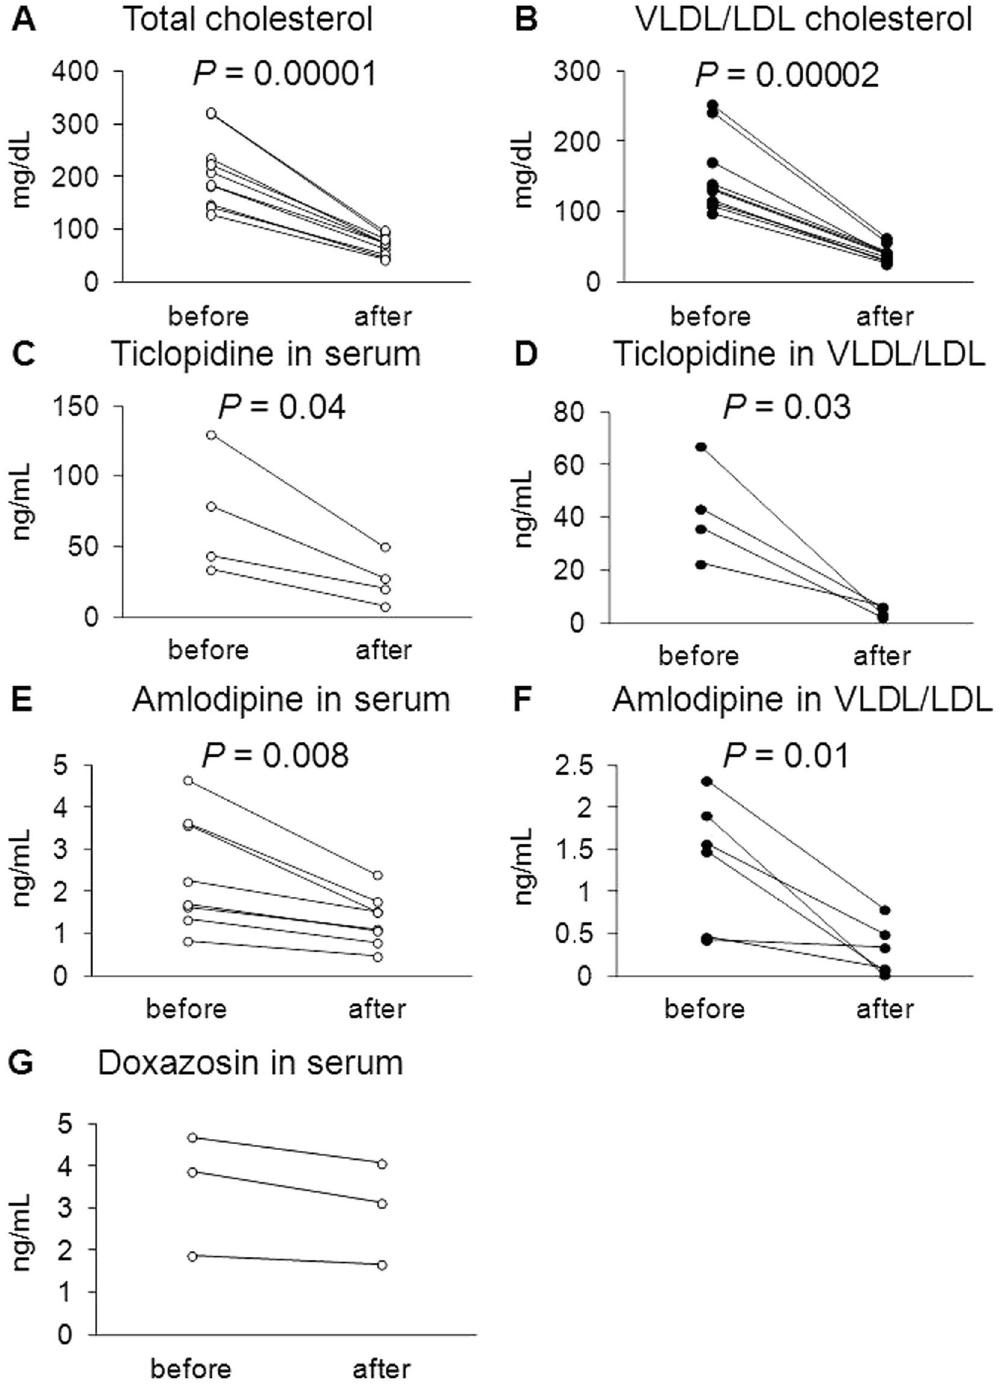
Figure 7. Effect of lipoprotein apheresis treatment on VLDL/LDL-associated drug behavior in patients with familial hypercholesterolemia. ( A ) Total cholesterol concentration in serum before and after lipoprotein apheresis treatment. ( B ) VLDL/LDL cholesterol concentration in serum before and after lipoprotein apheresis treatment. ( C , E , and G ) Drug concentrations in serum before and after lipoprotein apheresis treatment. ( C ) Ticlopidine; ( E ) amlodipine; and ( G ) doxazosin. ( D , F ) VLDL/LDL-associated drug concentrations before and after lipoprotein apheresis. ( D ) Ticlopidine and ( F ) amlodipine. ( A–F ) P values were determined using paired t